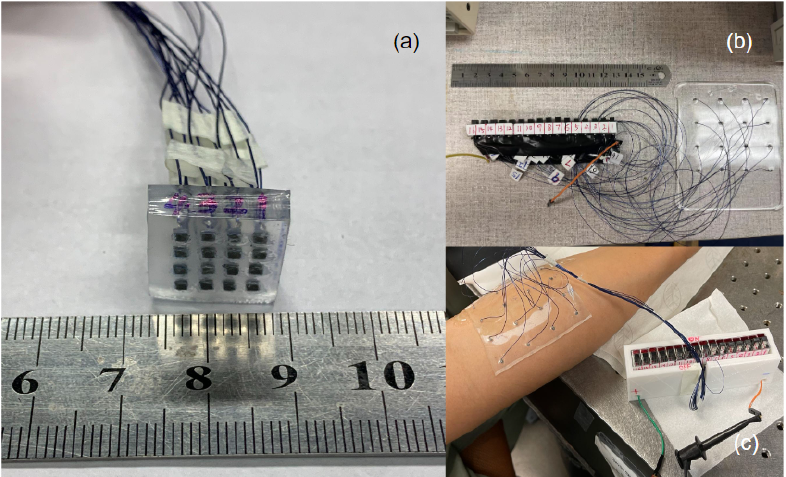
Figure 3. Demonstration of the wearability and customizability of the transducer: ( a ) size is about 1.5 cm, which can be used for single muscle measurements; ( b ) Size is about 10 cm, which can be used for multiple muscles measurements; ( c ) demonstration of flexibility for the wearable